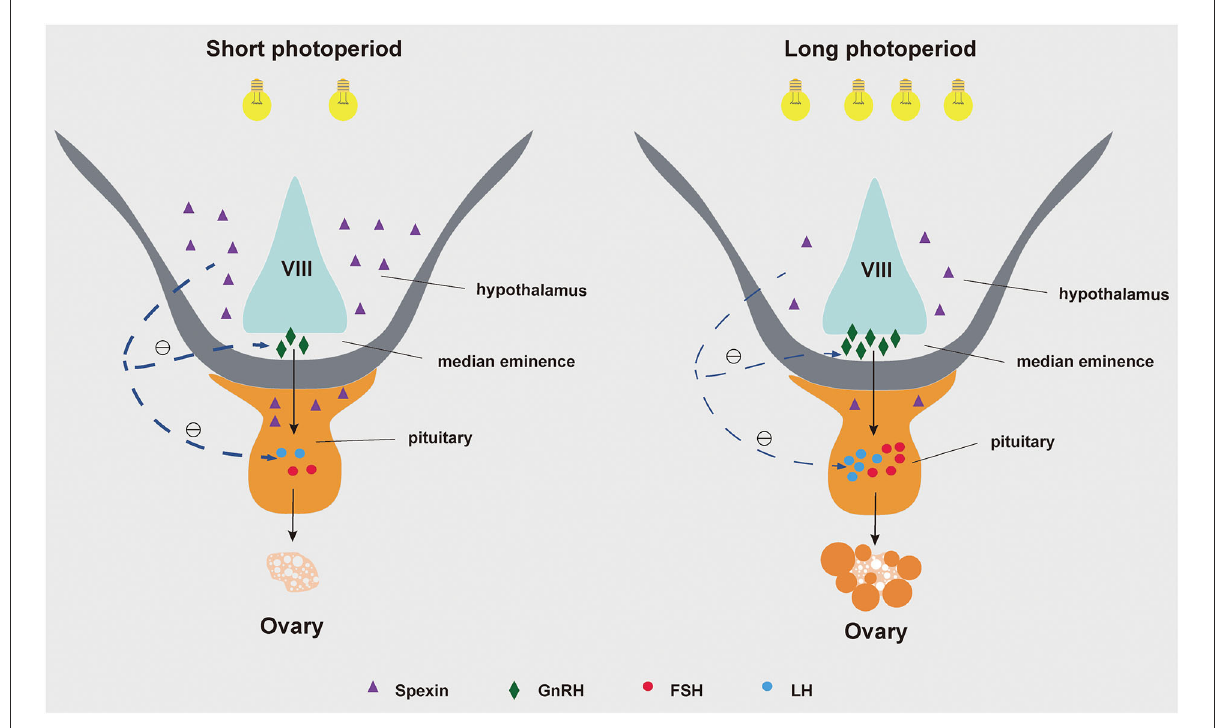
FIGURE6 A The role of spexin in goose reproduction during different